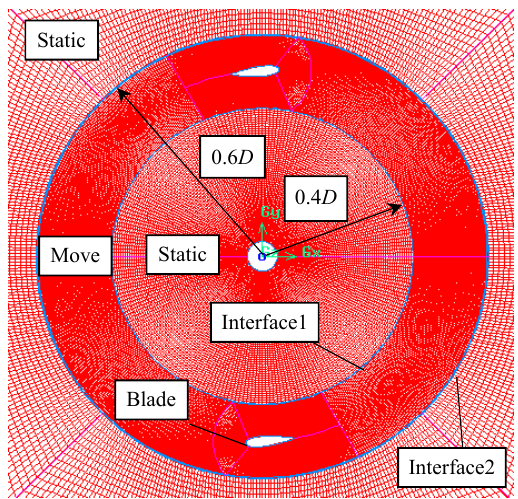
Figure 5. Rotating region mesh.